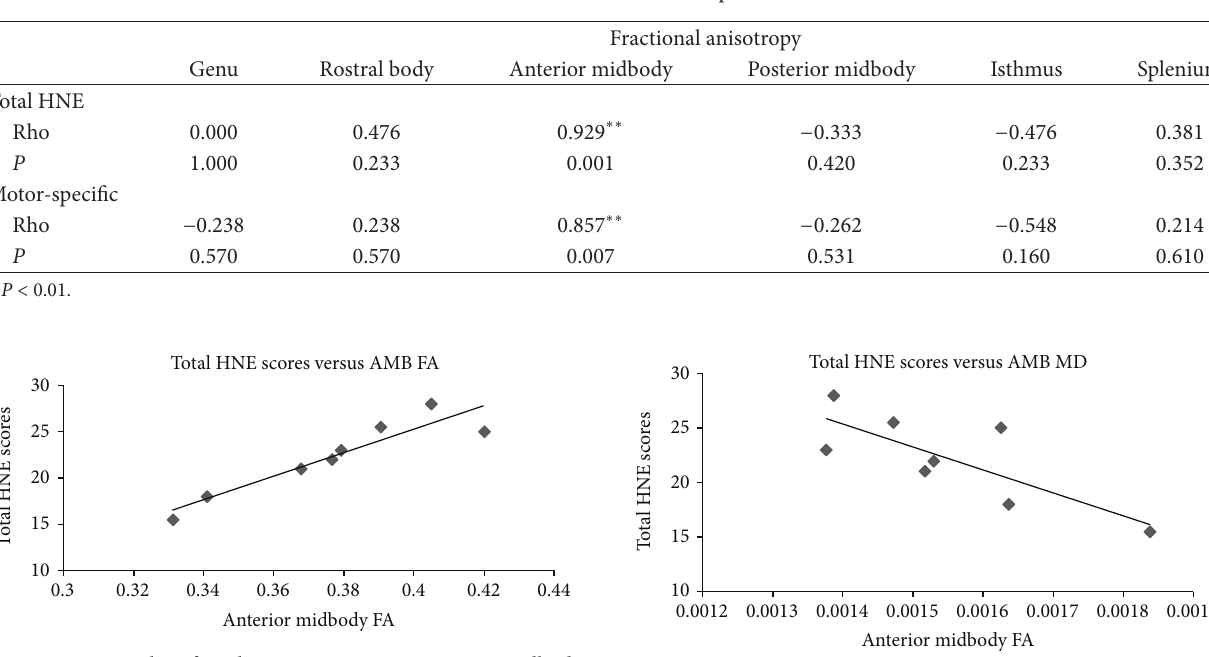
F 2: Scatterplot of total HNE scores versus anterior midbody